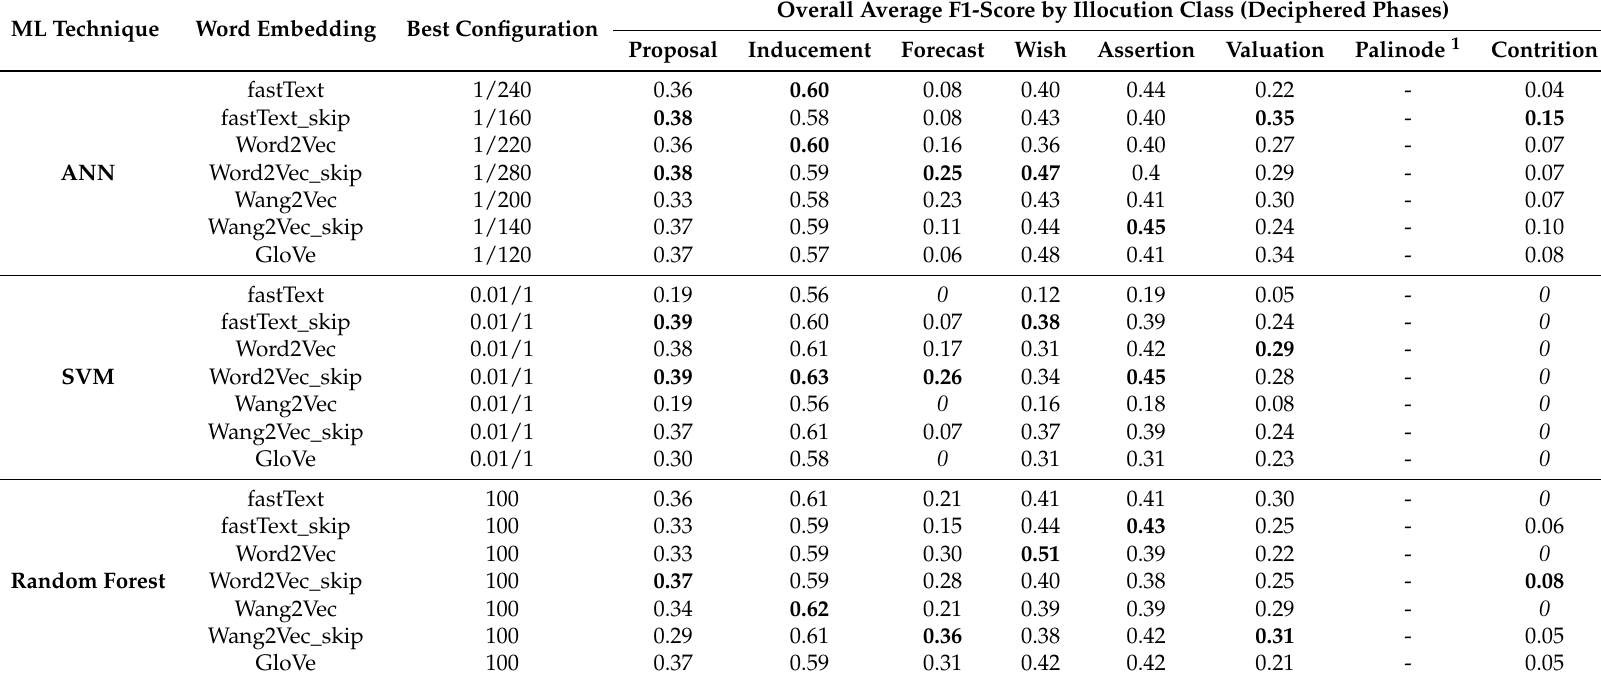
Table 3. Experimental results obtained with the ANN, SVM, and Random Forest classifiers with Deciphered Phases. Word embedding vector dimension: 600. Cross-validation method with k = 5. Average F1-score by illocution class